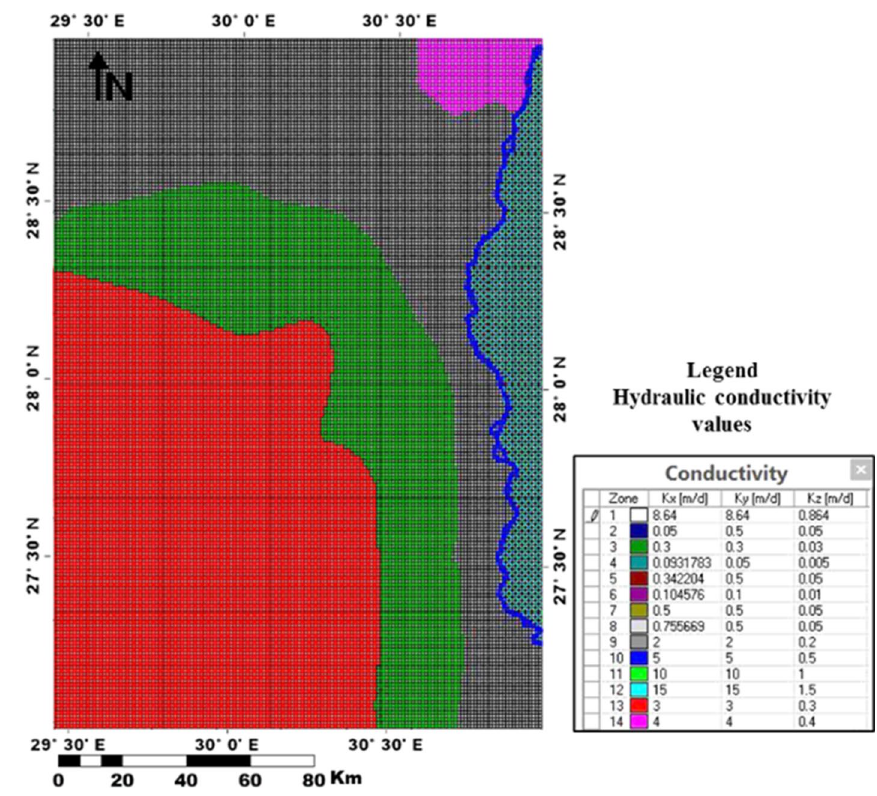
Fig. 13 Spatial distribution of calibrated hydraulic conductiv- ity values in Eocene aquifer, West–West Minya area